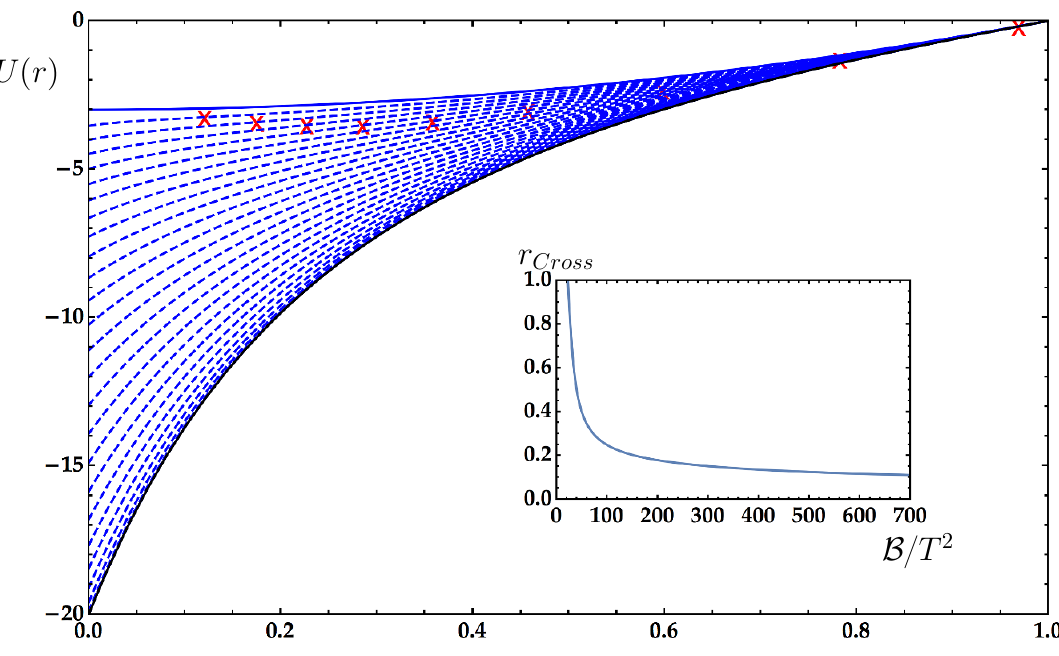
Figure 15 . The numerical solutions for the metric function U inside the horizon for values of =T 2 0, 0.68, 1.4, 2.1, 2.8, 3.6, 4.5, 5.4, 6.4, 7.5, 8.7, 10, 12, 14, 16, 19, 23, 28, 34, 43, 57, 78, 118, B (cid:25) 207, 534, are shown in dashed lines from bottom to top. For each solution U we indicated the place where its second derivative, with respect to r , changes sign, and in the inset we depict the radius r Cross where this change takes place as a function of =T 2 . The bottom solid line is the black brane B solutions and the top solid line is the BTZ R 2 (cid:2)